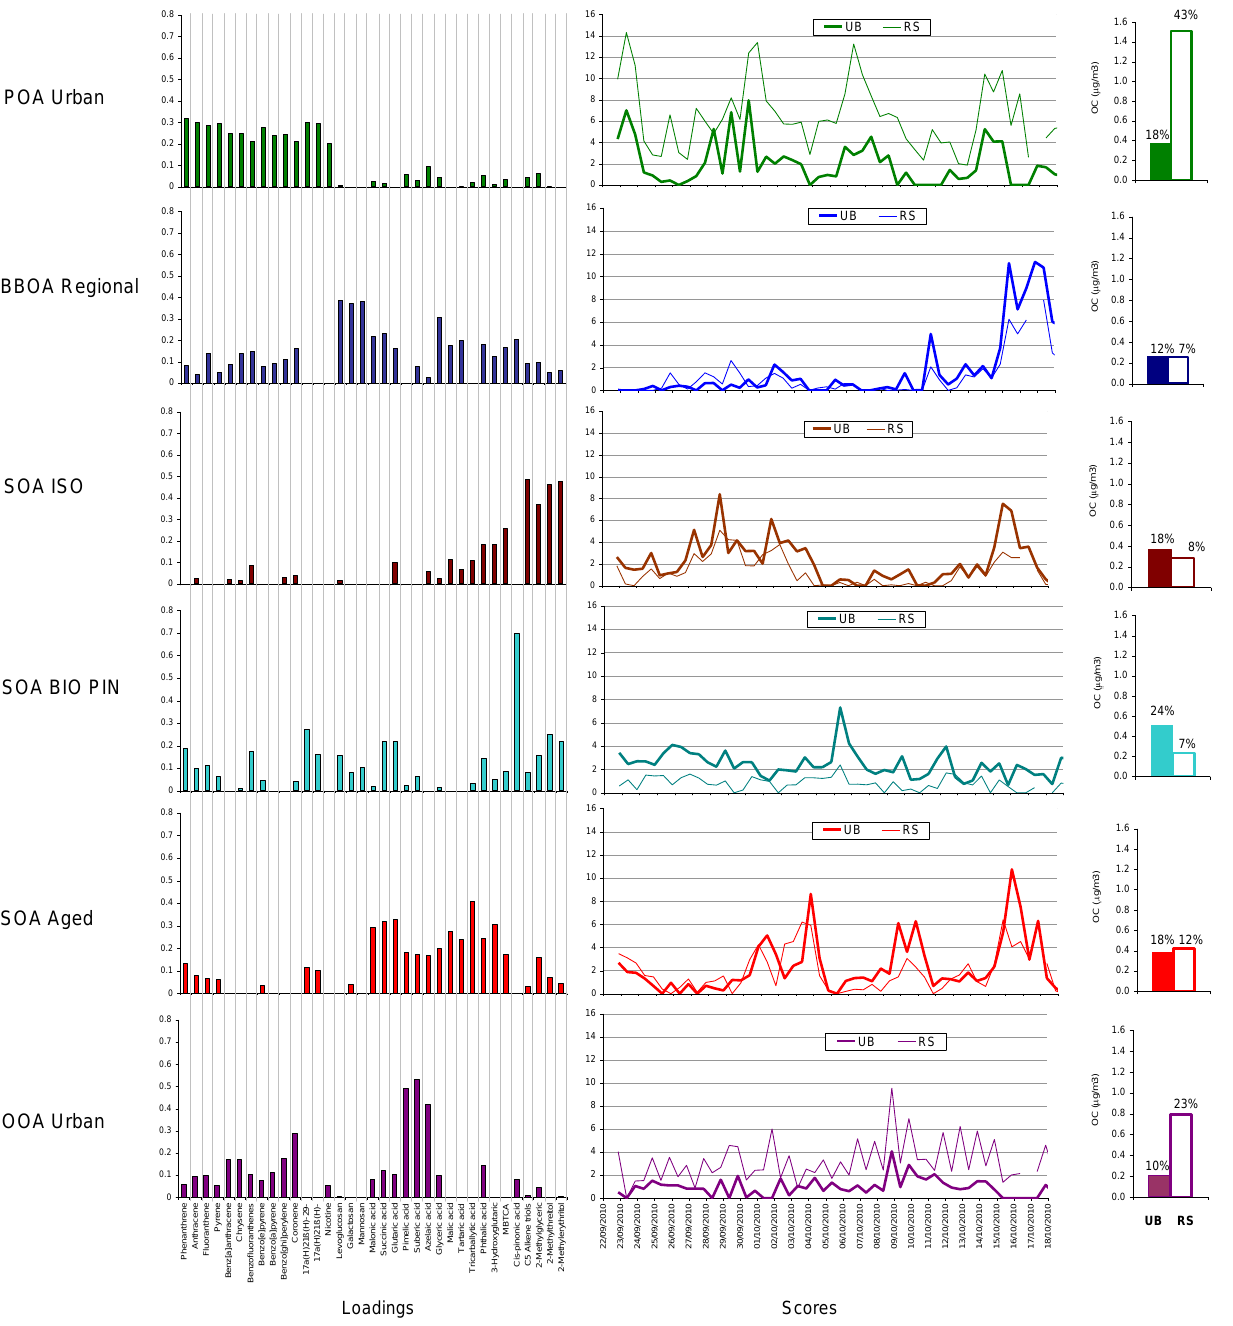
Fig. 2. MCR-ALS resolved profiles applying non-negativity constraints. Column on the left shows the loading organic compound composition of the six selected components. Column in the middle shows the temporal trend of the score values of the six components. Column on the right shows the relative contribution of the scores (%) as well as the estimated mass contribution of organic carbon to volume (µgOCm − 3 ) .